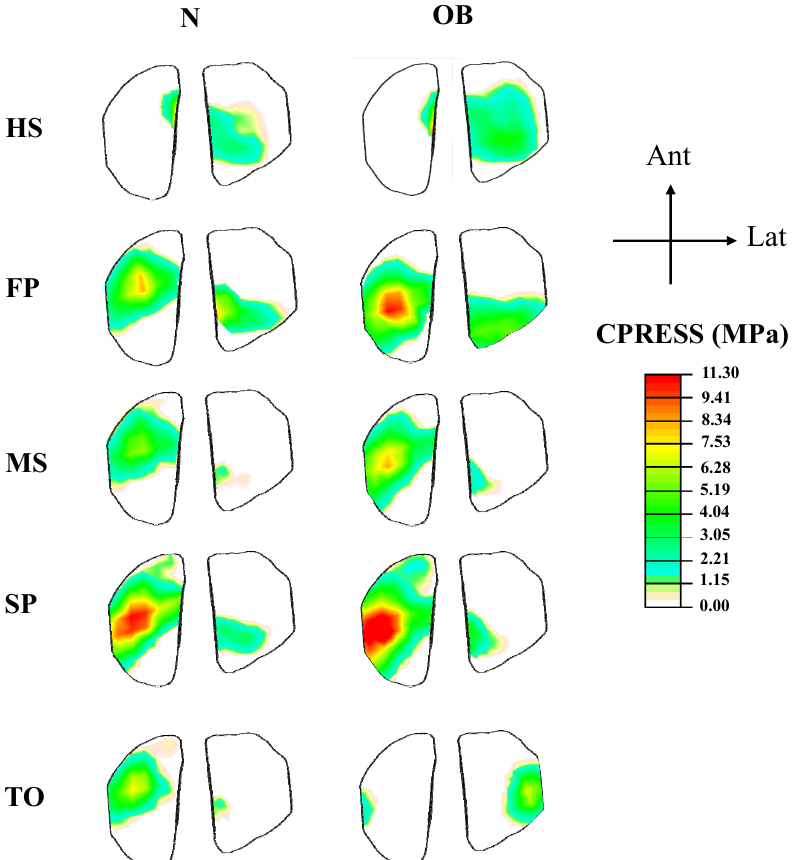
Figure 9. Contact compressive stress at articular surfaces of tibial compartments at different instances in normal and OB models. The common legend is employed for easier comparisons.